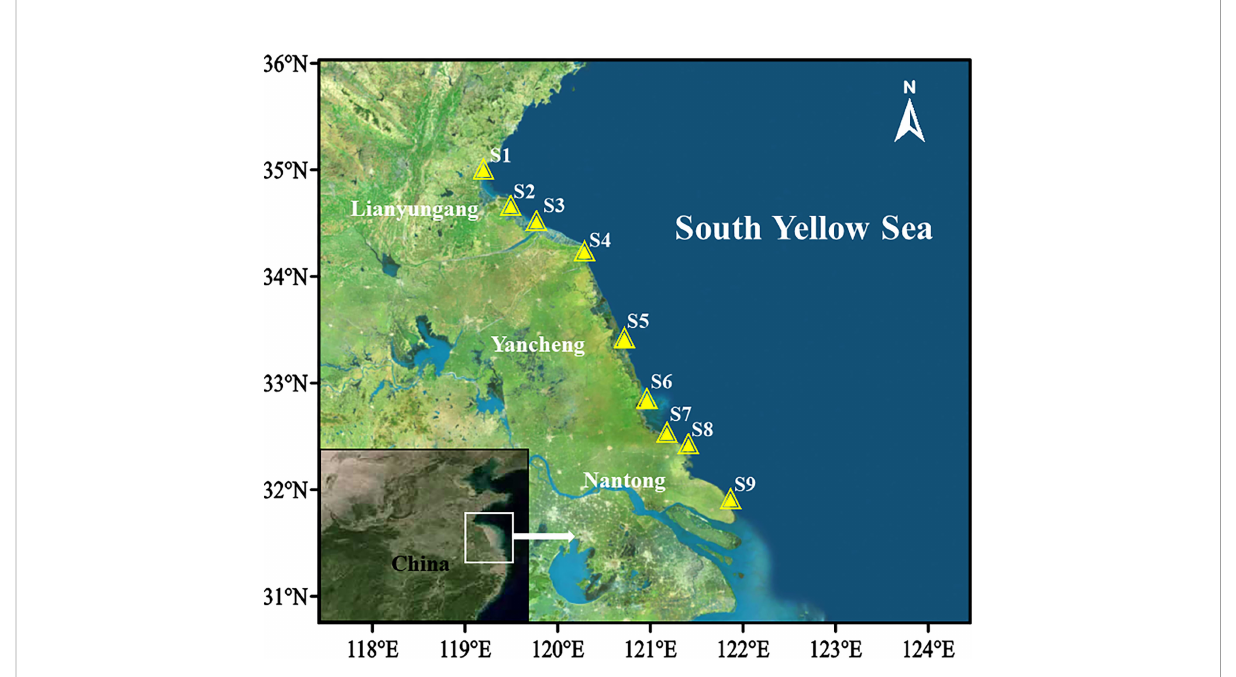
FIGURE 1 Geographical location of 9 sampling sites (3 regions) along the coast of South Yellow